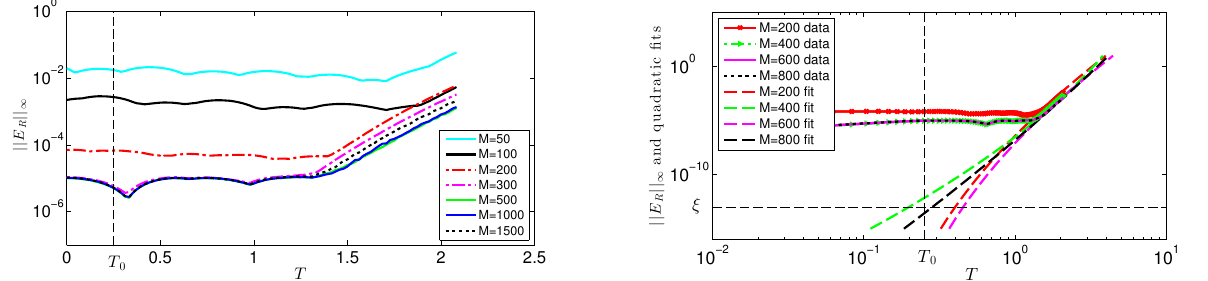
|| in the four-pole example with the added perturbation R ∞ = 0 . 25 , while the horizontal 0